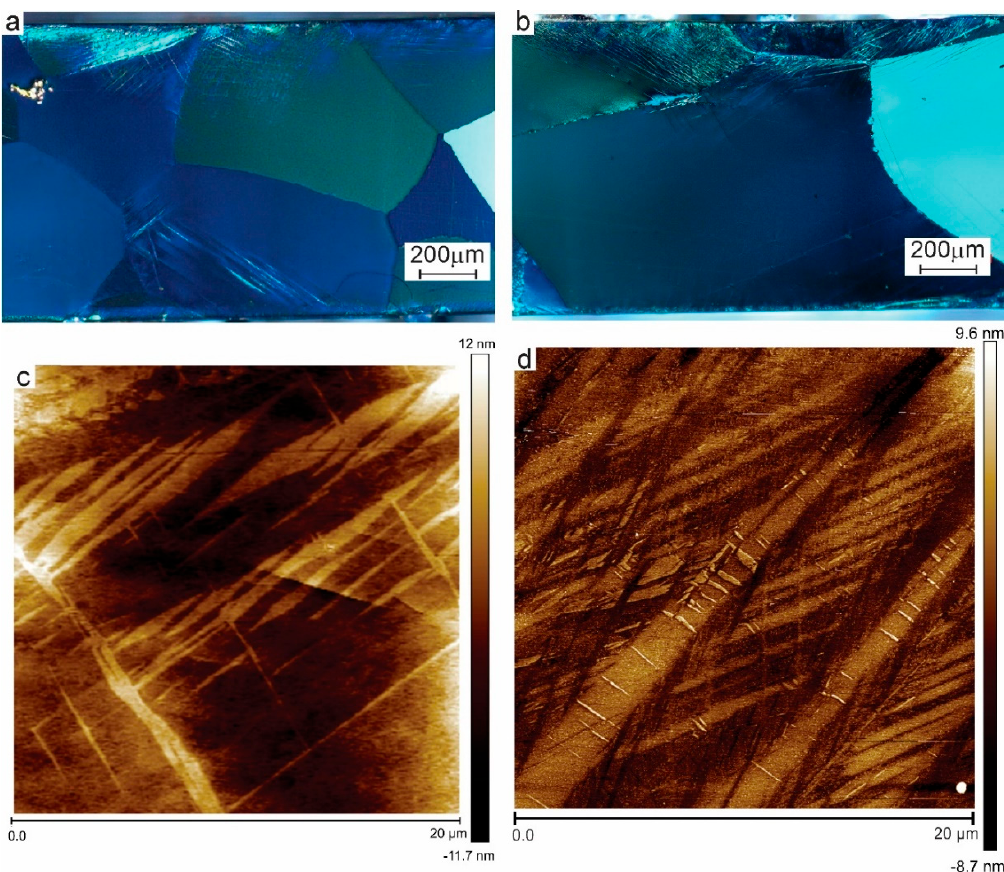
Figure 4. Transverse sections through the modified zones. ( a ) shows the AC material under crossed polarisers, ( b ) shows the same result on HR material, both indicating the presence of very fine intersecting platelets. ( c ) Contact mode AFM observation of nanostructured AC-material and ( d ) contact mode AFM observation of nanostructured HR-material, both representing the upper 20 µm of the modified grains.